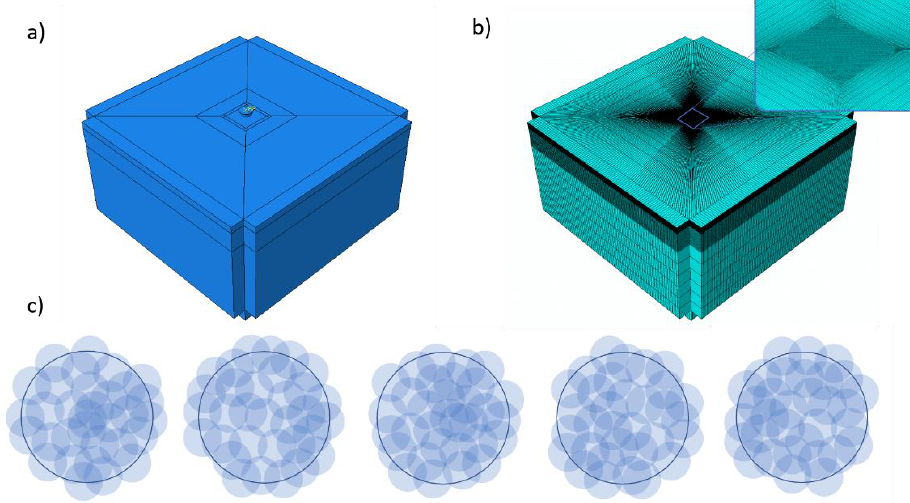
Figure 1. ( a ) Geometry ( b ) and mesh details of the numerical model; ( c ) the comparison between the arrangements of the shots in the five FE analyses. Table 1. Material parameters used in the modeling (data taken from